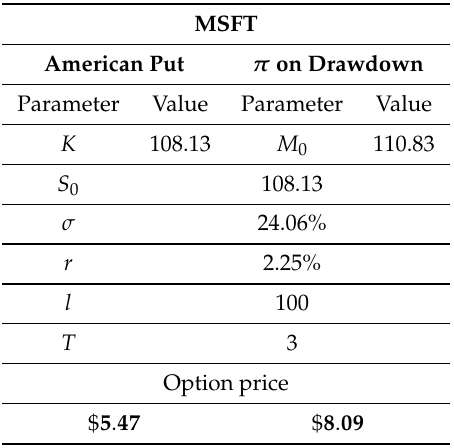
Table 4. Input parameters for computation and estimated options’ prices for the MSFT dataset.